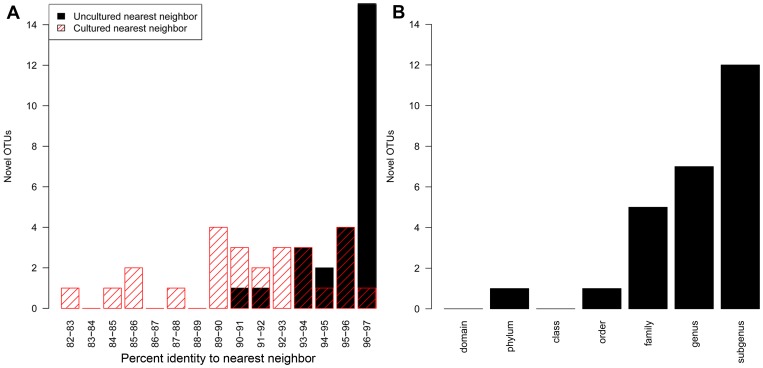
Novelty at different taxonomic levels.(A) Distribution of novel OTUs as a function of the maximum percent identity of a constituent read to a nearest neighbor for (black) all reads in the RDP and NT databases and (red) cultured reads. (B) The distribution of novel OTUs as a function of the lowest taxonomic rank that was confidently (with a bootstrap value of >0.5) assigned to a constituent read.